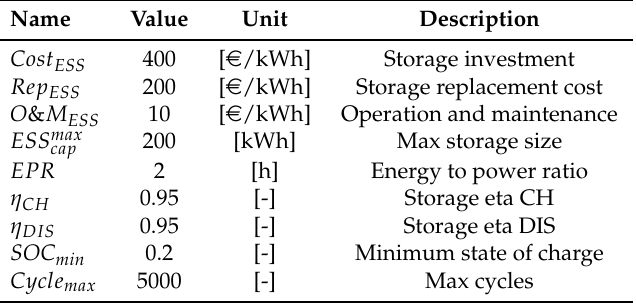
Table 4. Storage